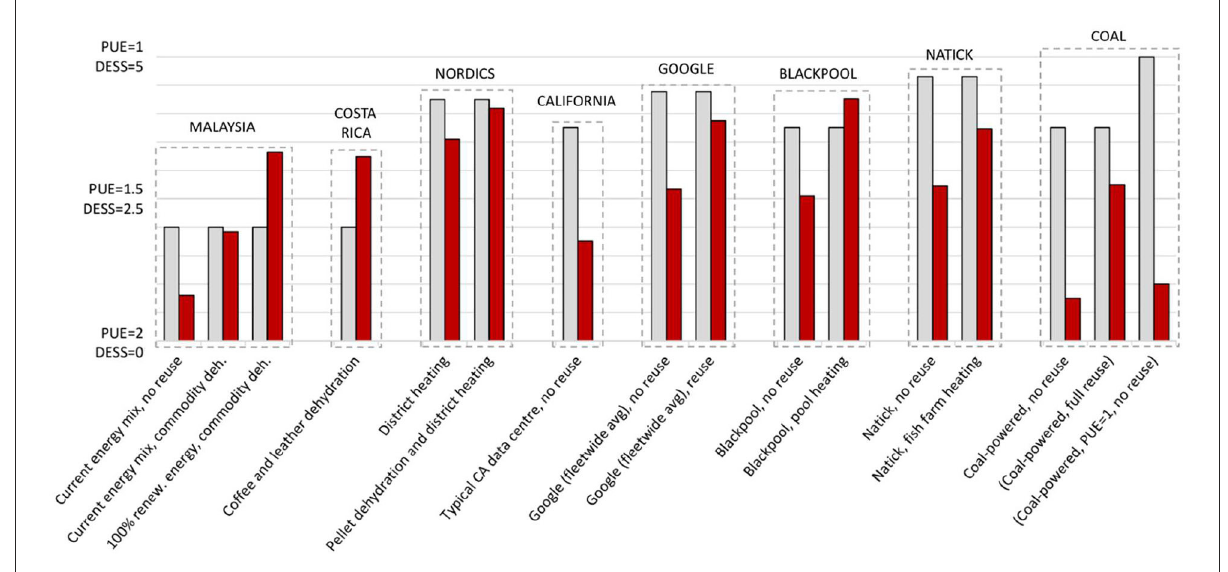
FIGURE7 A number of comparison cases for PUE and